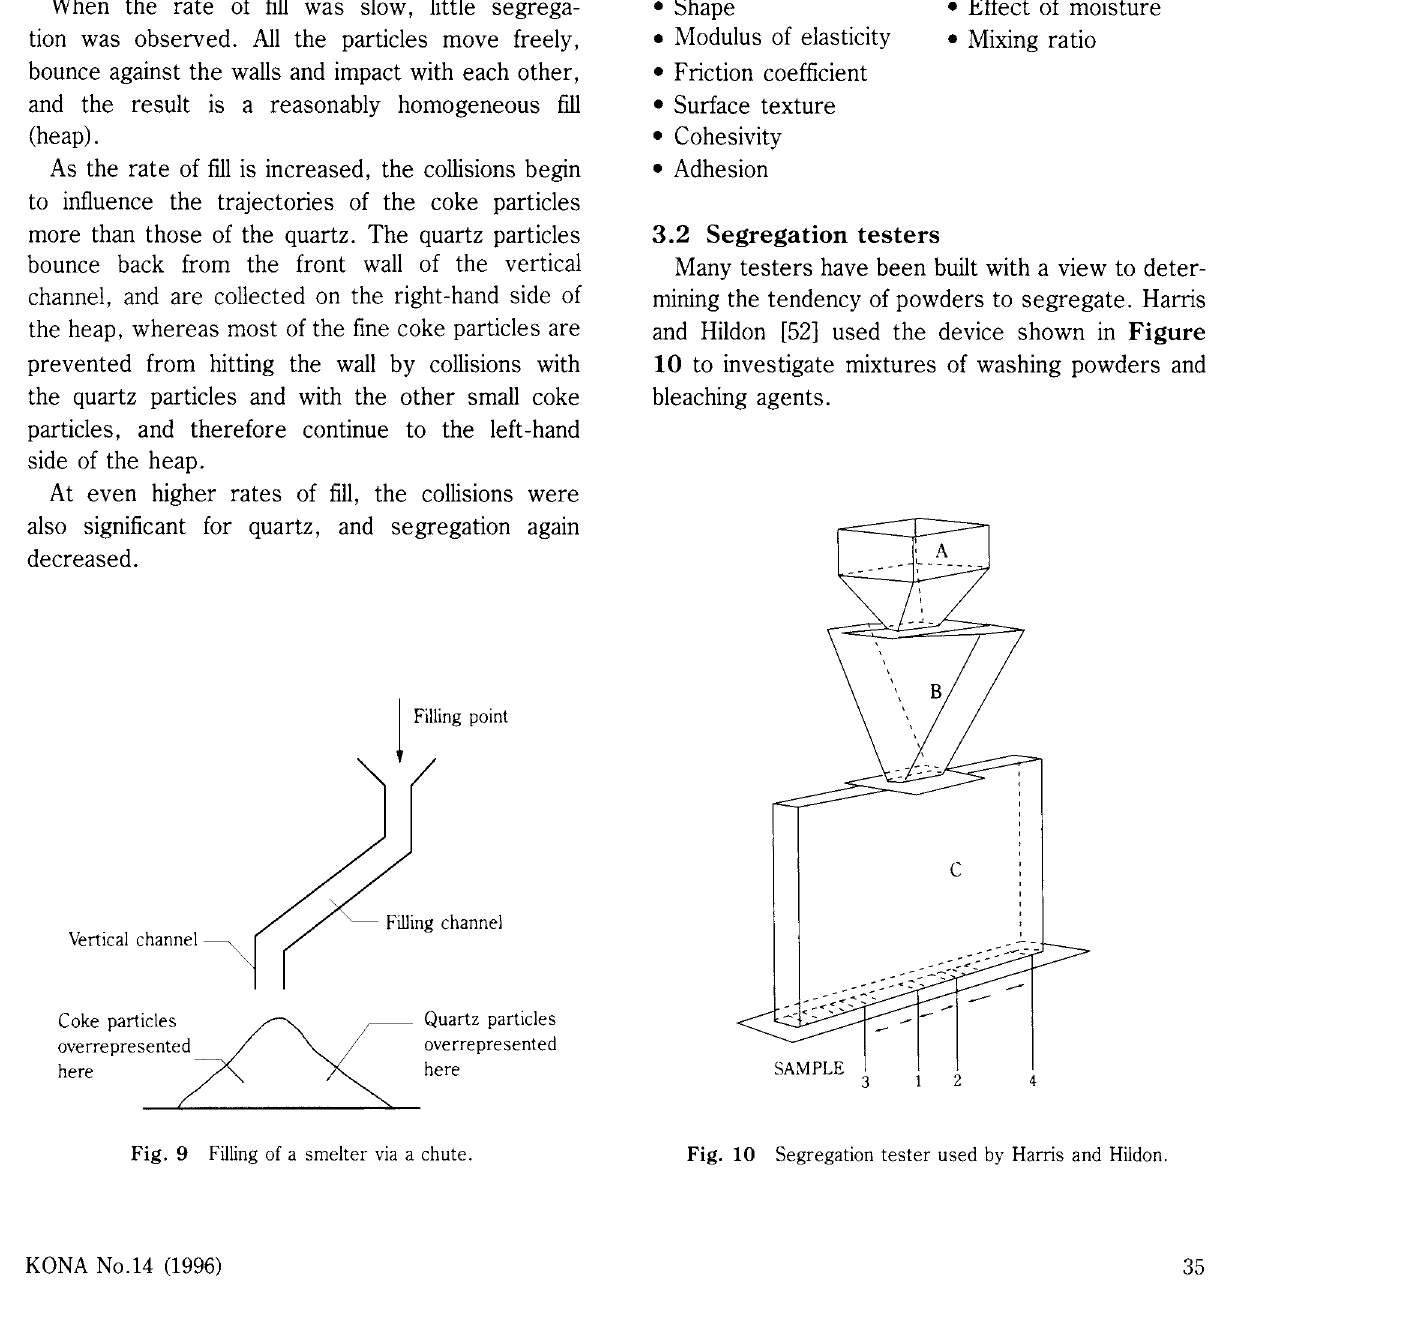
Fig. 10 Segregation tester used by Harris and